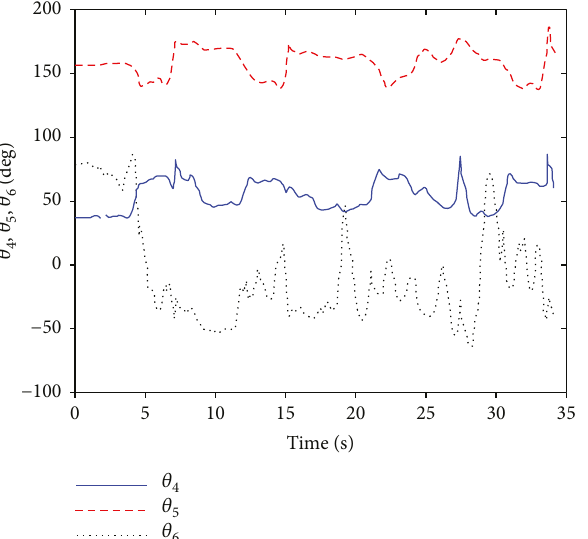
Figure 15: Comparison of protraction obtained by prediction and measurement (ABD).